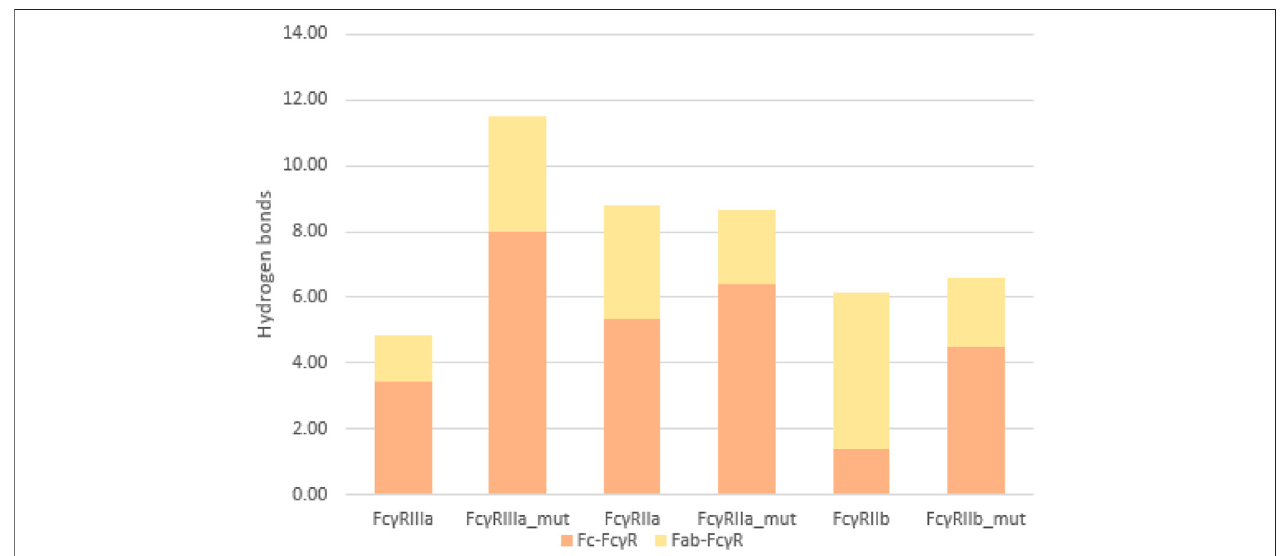
FIGURE 8 | Average number of hydrogen bonds formed between the Fc γ R and the antibody during simulation: comparison between the Fab-Fc γ R (yellow) interactions and the Fc-Fc γ R interactions (orange).